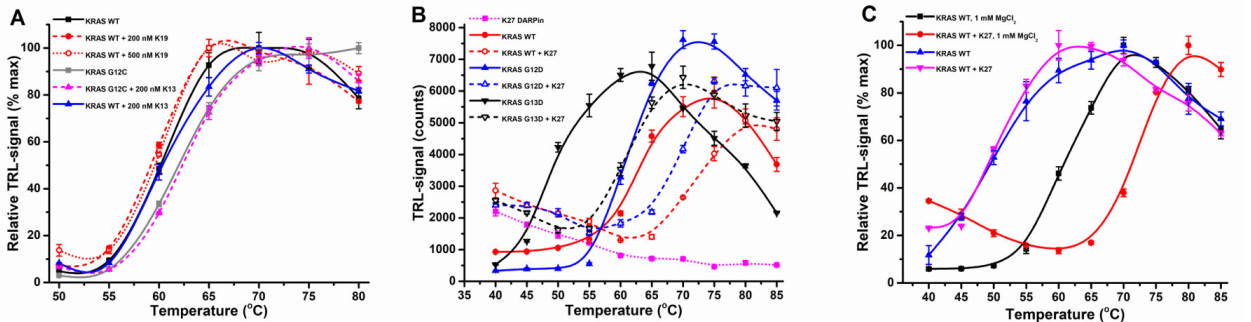
Figure 5. KRAS thermal stabilization by DARPins in the Protein-Probe assay. ( A ) Neither DARPin K13 nor K19 stabilized KRAS WT or G12C (50 nM). K19 (red) did not stabilize KRAS WT (black) at 200 (red dashed) or 500 nM (red dotted). Similarly 200 nM K13 had no effect on KRAS WT (black compared to blue solid lines) or KRAS G12C (gray solid line compared to magenta dashed line). ( B ) DARPin K27 (100 nM) showed a similar degree of stabilization with 50 nM KRAS WT (red), G12D (blue), and G13D (black). DARPin K27 (magenta) was responsible for the signal in the Protein-Probe assay at low temperatures. ( C ) DARPin K27 (100 nM)-induced thermal stabilization of KRAS WT (50 nM) was Mg 2+ -dependent. In addition, 1 mM MgCl 2 stabilized KRAS (black compared to blue) and was also necessary for K27-induced stabilization (red compared to magenta). Data represent mean ± SD ( n =